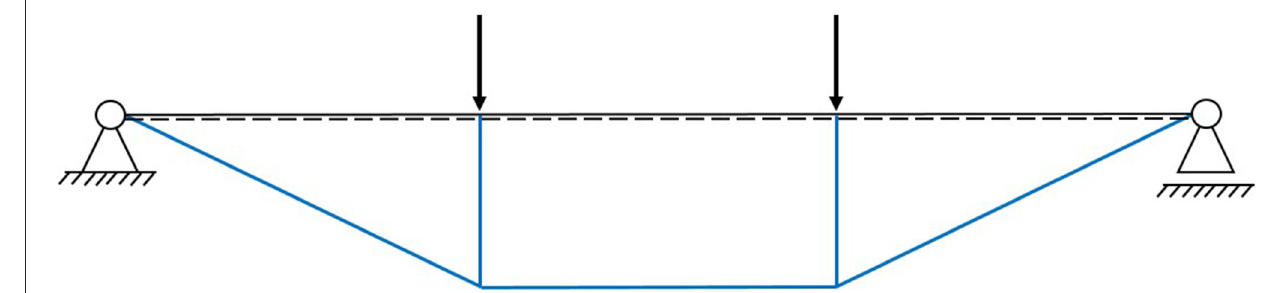
FIGURE 4 | Single-span beam with two single loads and the corresponding bending moment diagram.